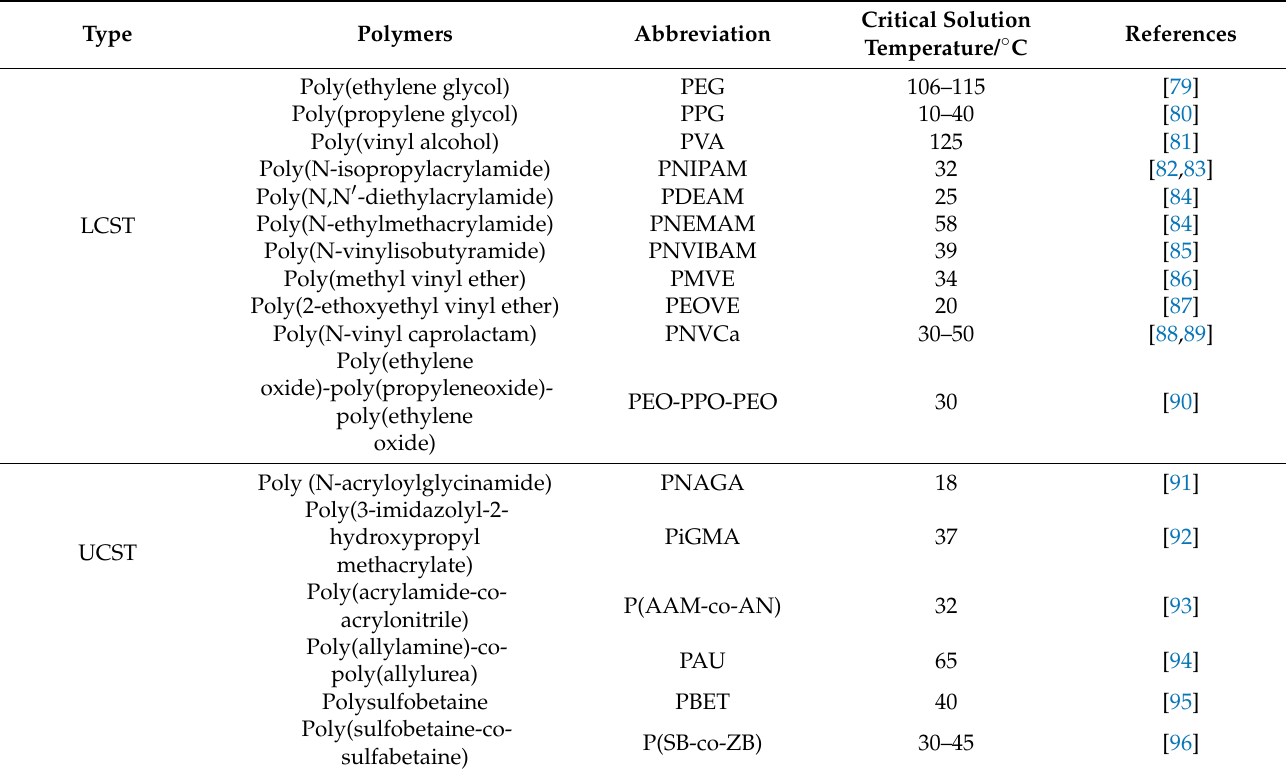
Table 2. Typical polymers used in thermoresponsive